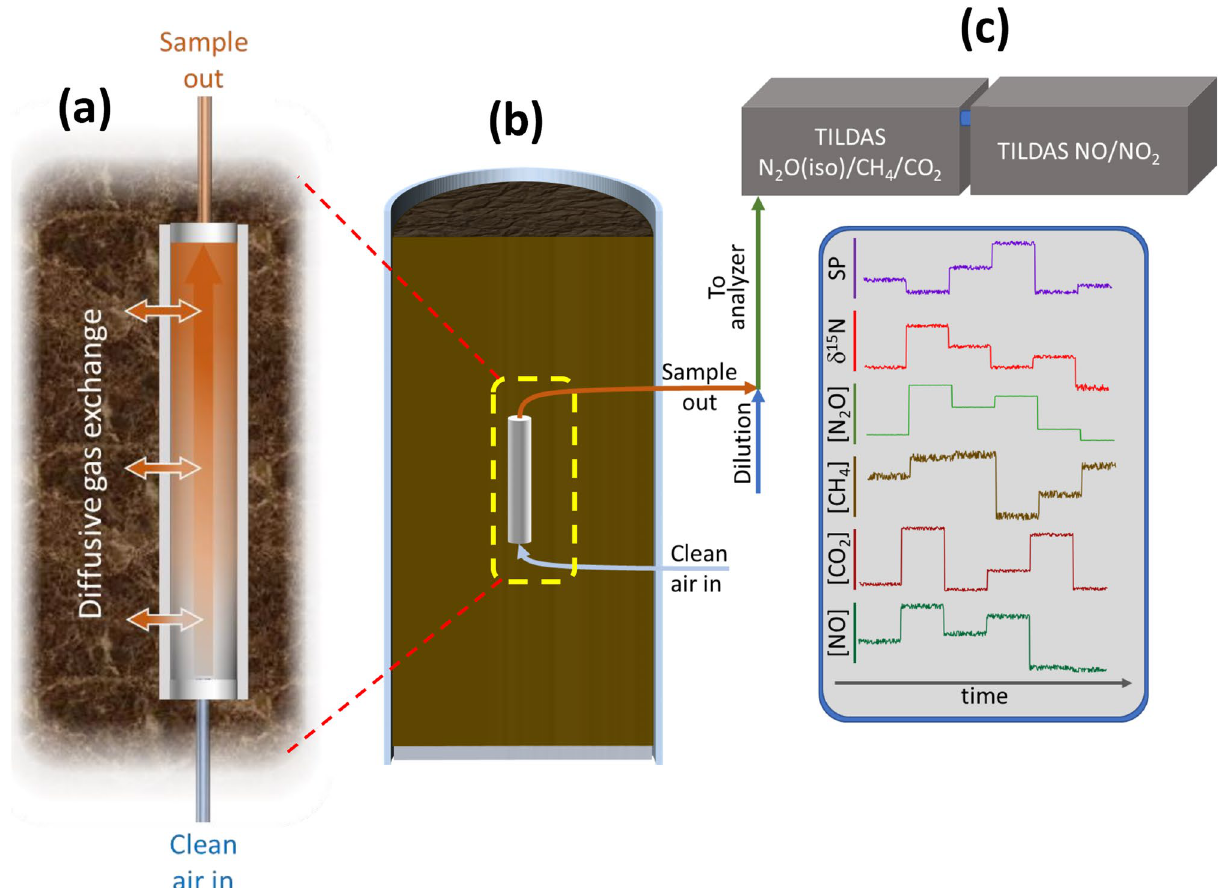
Figure 1. ( a ) Diffusive exchange across sPTFE membrane. ( b ) Probe mounted in the soil column. Sample air exiting the probe is diluted and transferred to analyzers ( c ) that measure time series of concentrations and isotopic ratios from multiple